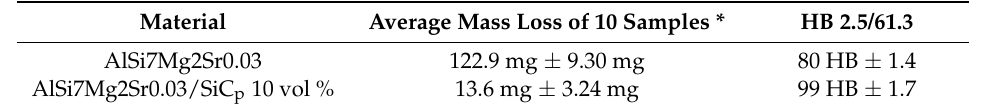
Table 3. Comparison of matrix alloy and composite.